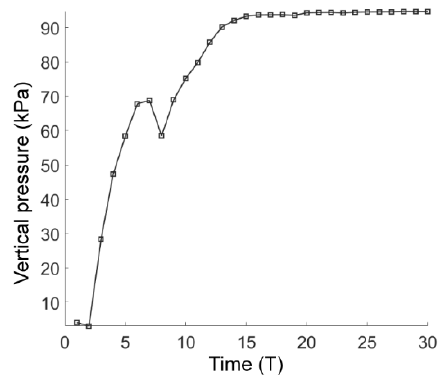
Figure 11. Average vertical pressure on the tunnel lining as a function of computational time.